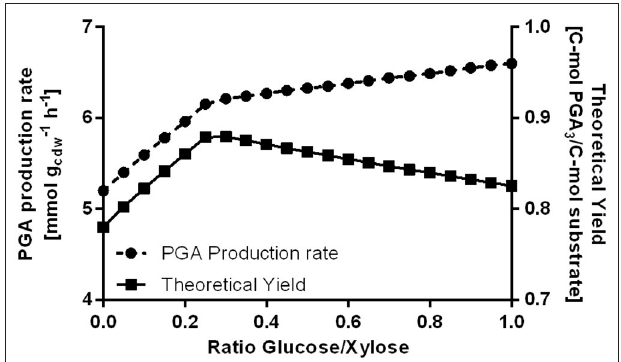
FIGURE 9 | Modeling the γ -PGA production rate and the theoretical yield for varying substrate ratios. The total substrate uptake rate was kept constant at 20 mmol g − 1 cdw h − 1 . The biomass formation rate was set to 25 mmol g − 1 cdw h − 1 and the ATP maintenance coefficient was 9.9 mmol g − 1 cdw h − 1 .